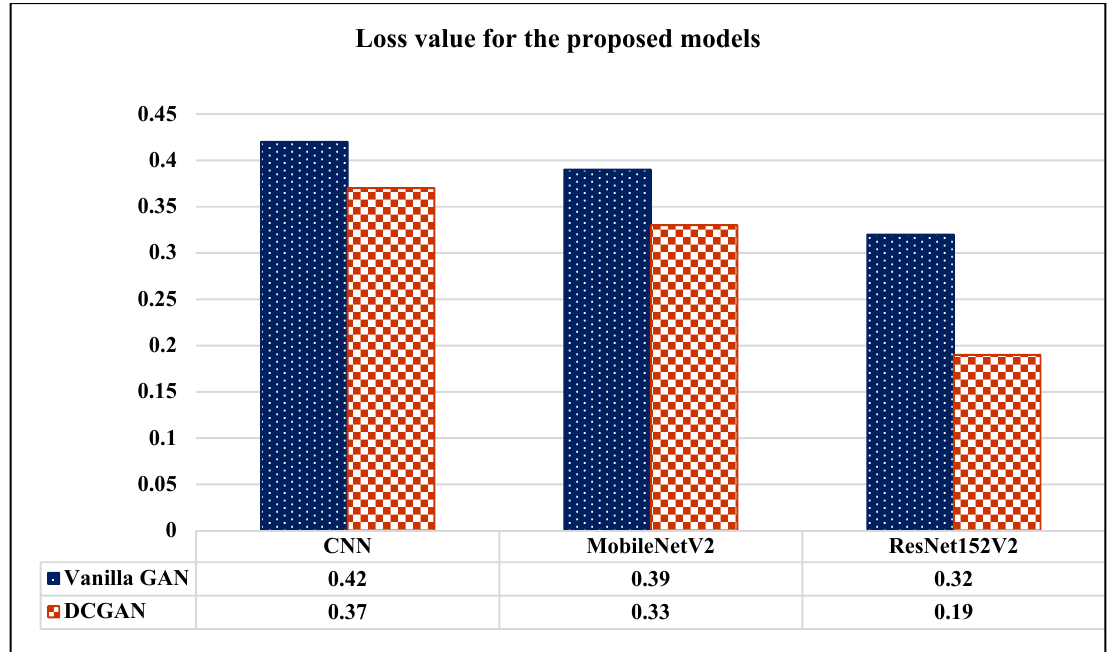
Figure 14. Loss measures for the CNN, MobileNetV2, ResNet152V2 models using Vanilla GAN and DCGAN image generated.